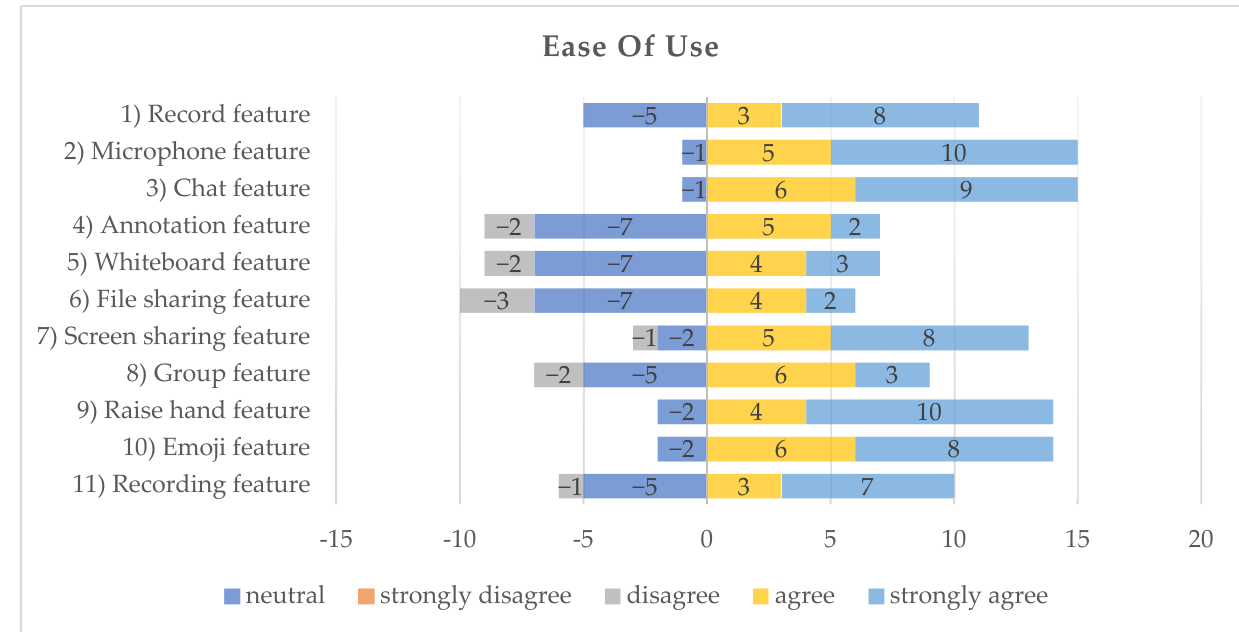
Figure 4. Distribution of user’s perceived ease of use of the features on virtual conferencing tool.